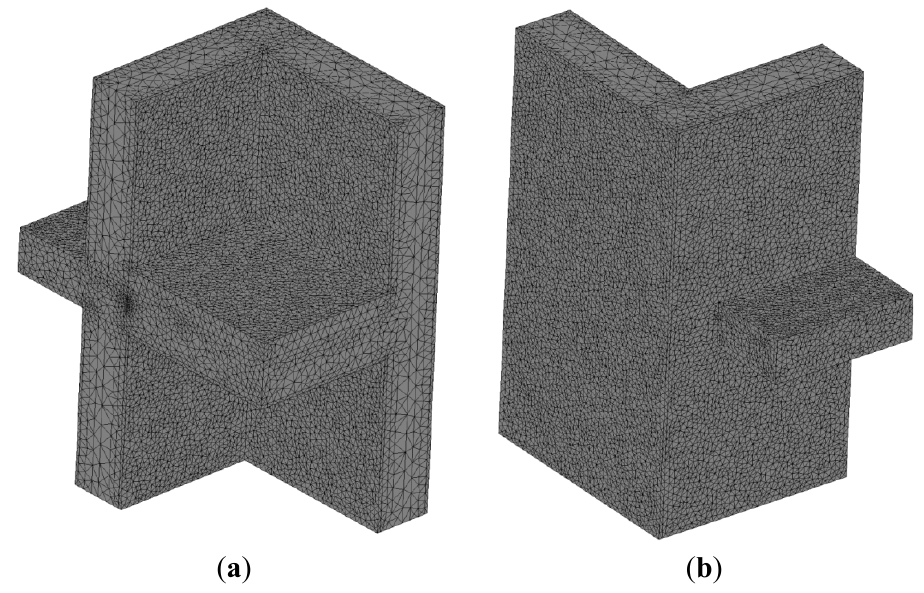
Figure 7. Computational grid employed (74,771 nodes and 403,175 tetrahedral elements): front view ( a ) and rear view ( b ).